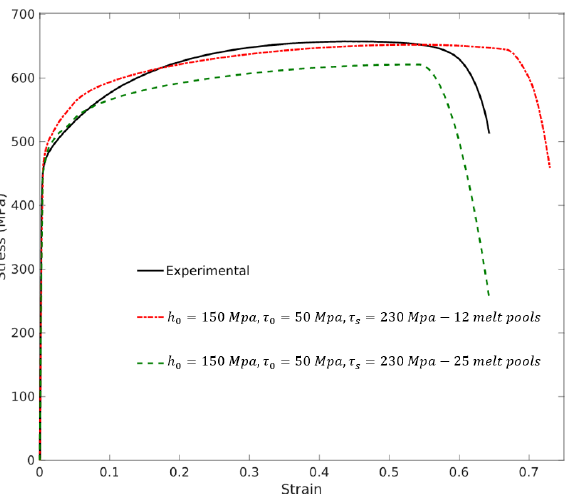
Figure 13. The influence of changing melt pool numbers for RVE with 199 grains on engineering stress-strain